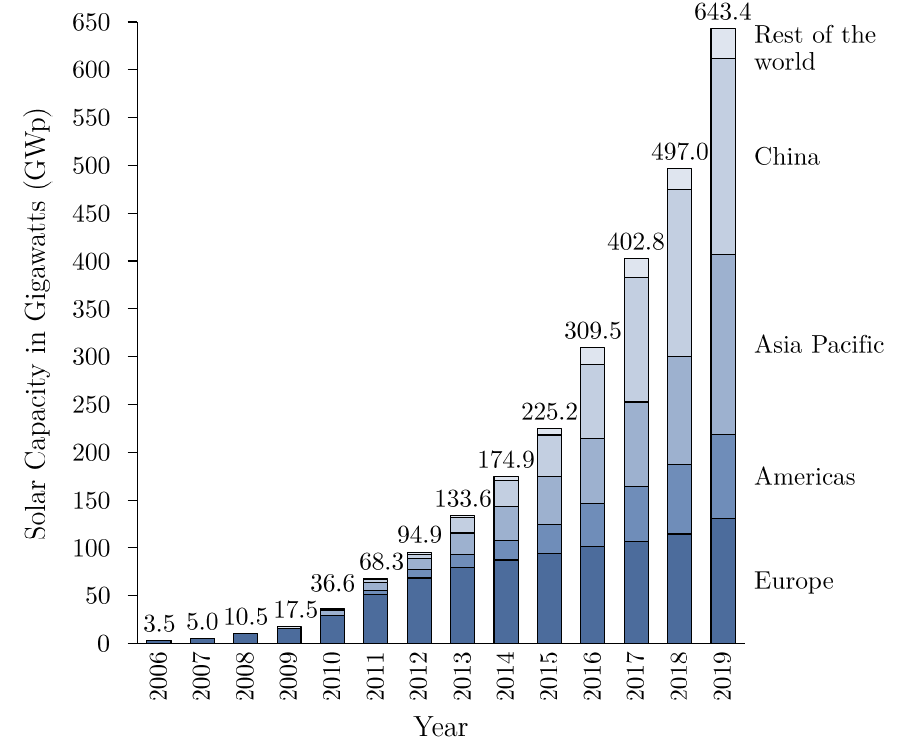
Figure 1. Growth of global photovoltaic capacity has been exponential over the last two decades, from 0.3 GW in 2000 to 63.5 GW in 2019, roughly doubling every 18 months [2,3]. Existing databases of solar generating capacity are insufficient to address databasing needs because they are either aggregated (for example, those of the IEA2, IRENA3, or